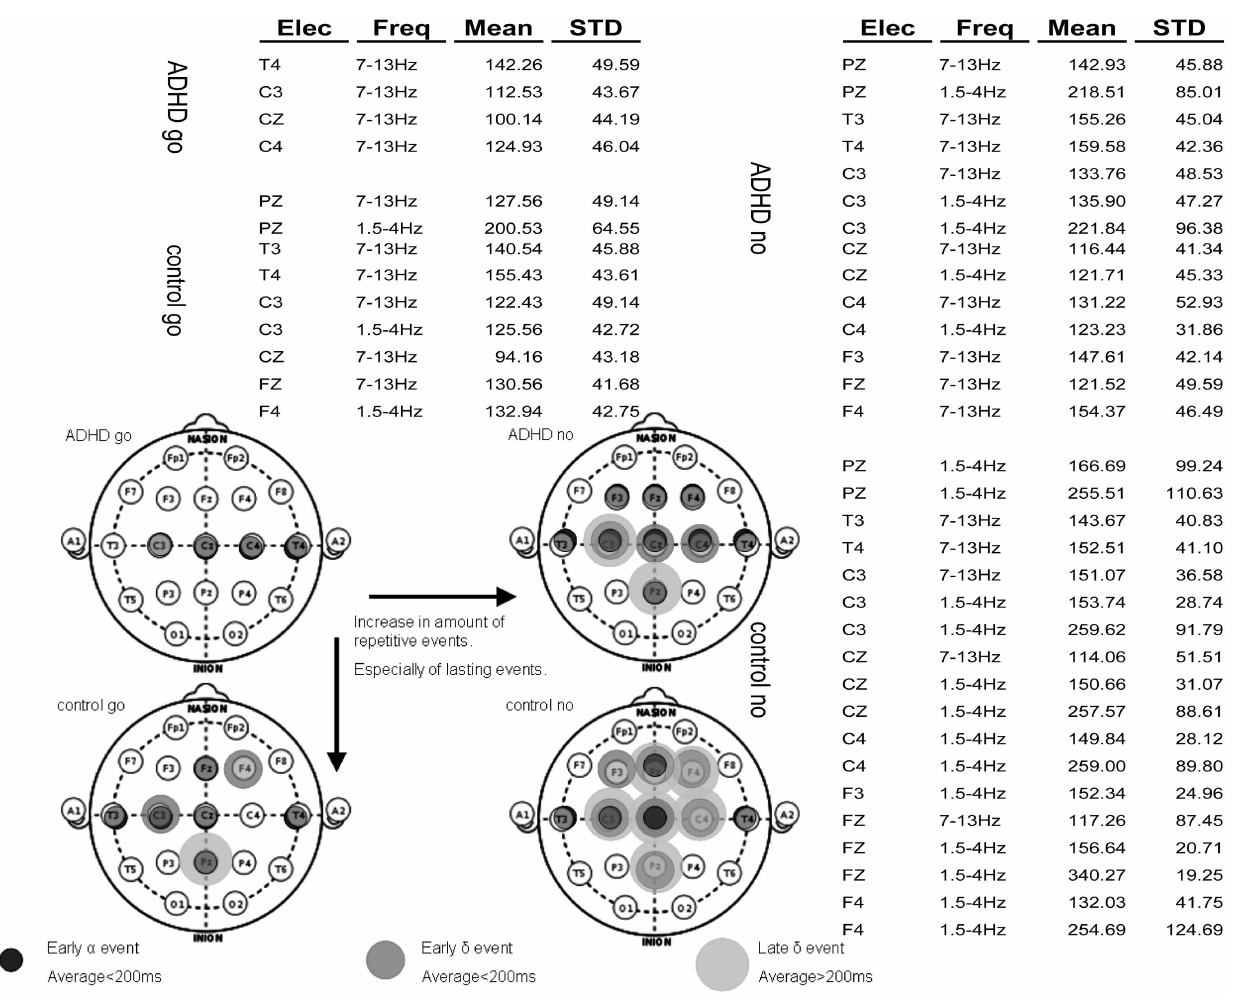
FIGURE 6 | Summary of repetitive events in the various experimental conditions:ADHD-go (top right),ADHD-no-go (top left), control-go (bottom right), control-no-go (bottom left) .Three types of repetitive activity can be found by applying the analysis method described: (i) early alpha